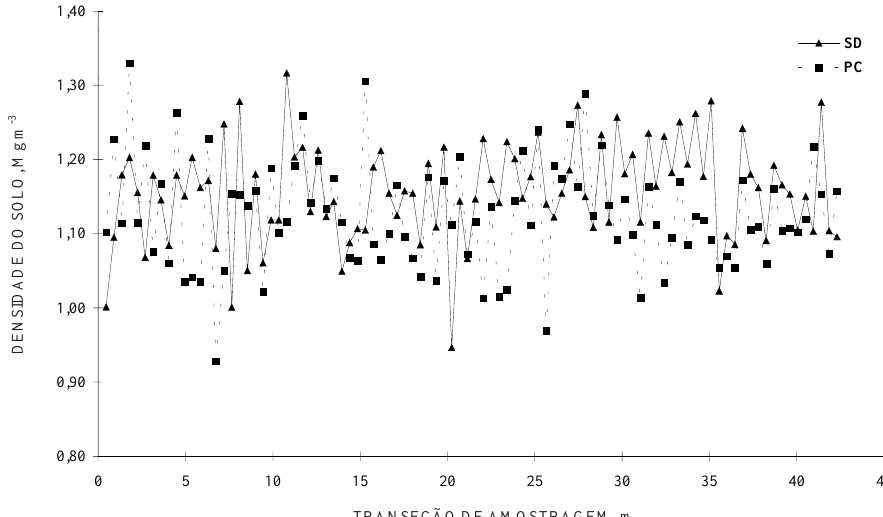
Figura 2. Densidade do solo ao longo da transeção de amostragem nos sistemas de semeadura direta (SD) e preparo convencional (PC) num Latossolo